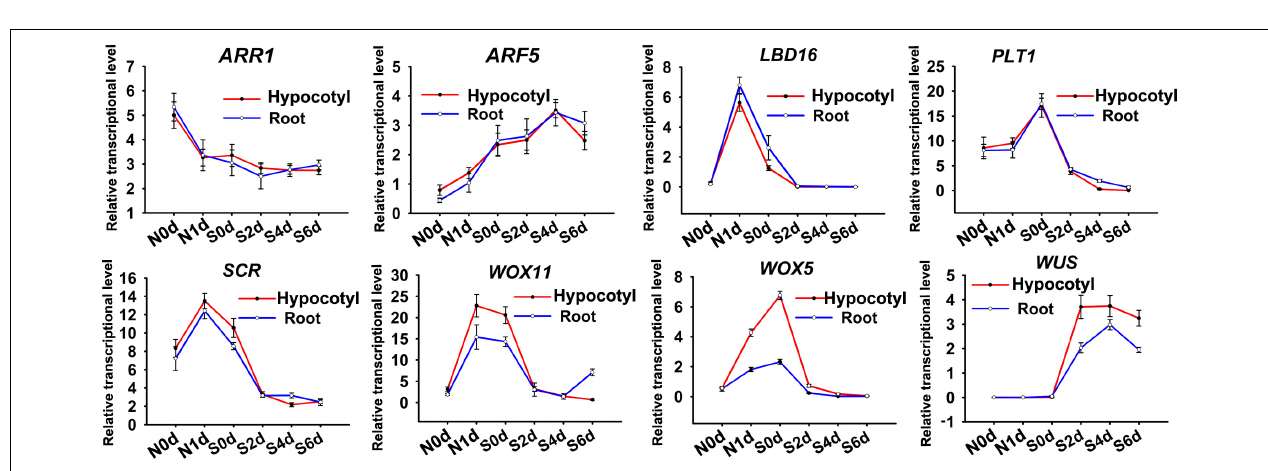
FIGURE 3 | qRT-PCR analysis of genes involved in shoot regeneration. N represents days after NAA treatment. S indicates days for SIM incubation. Error bars show standard deviations of three biological repeats.